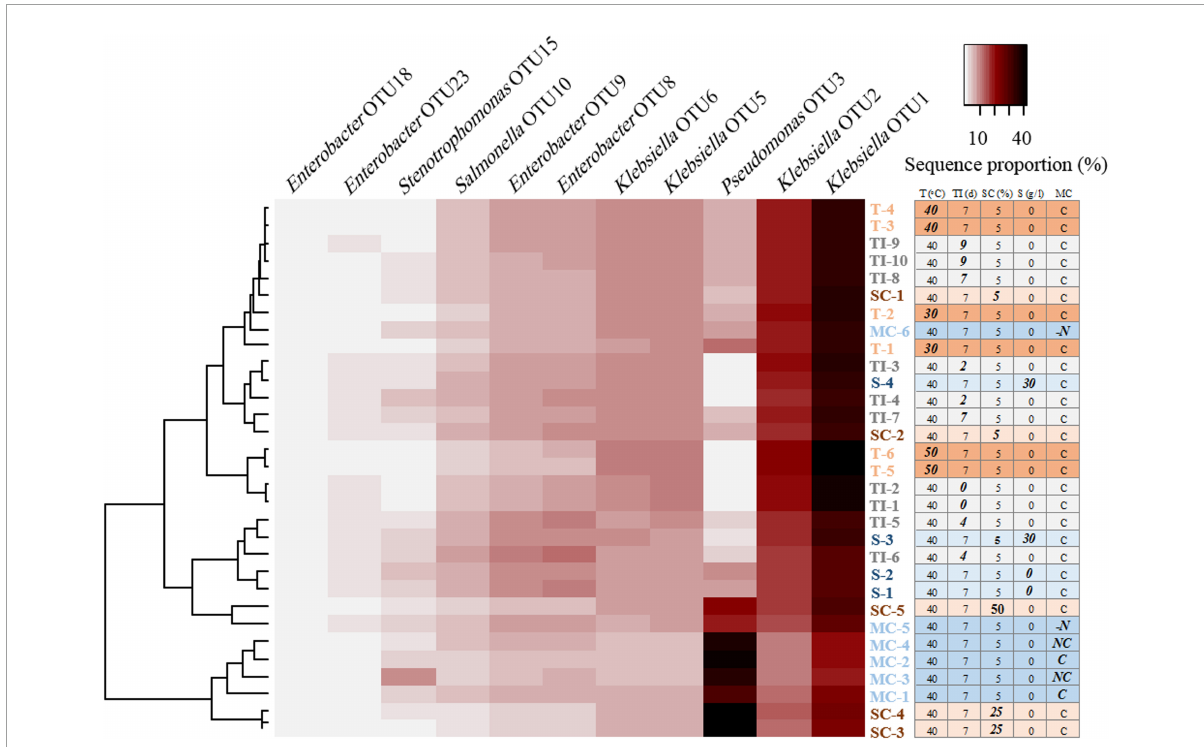
FIGURE4 A heatmap representing comparing the relative abundance (% of total sequences) of the most abundant OTUs in the AK6 bacterial culture under different conditions of oily sludge biotreatment, indicated by the table. T: temperature, TI: incubation time, SC: sludge concentration (%, w/v), S: salinity (g/L), MC: medium composition [C: complete medium, NC: without complement (vitamins, trace elements, MgCl 2 , CaCl 2 and FeCl 2 ), -N: without nitrogen